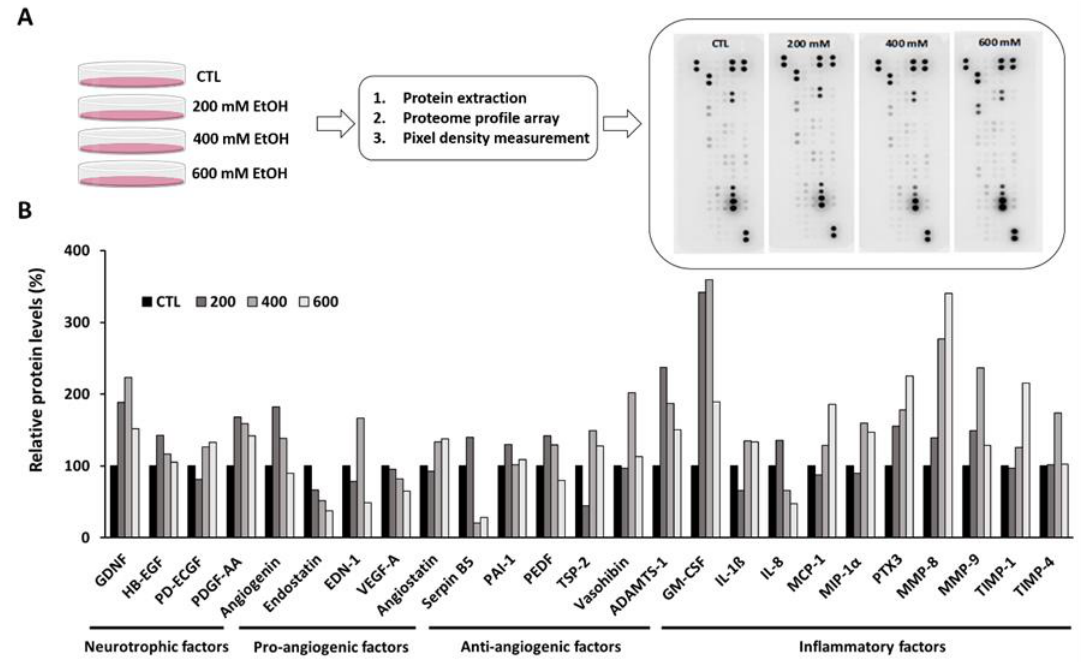
Figure 2. Proteome profile in ARPE-19 cells after EtOH exposure. ( A ) Workflow of the semi-quantitative proteomic analysis by antibody array system after 24 h of 200, 400 and 600 mM EtOH treatment in ARPE-19 cell. ( B ) Main neurotrophic, angiogenic and inflammation factors that experienced major changes. Values are expressed as the mean of pixel density signal of the pair of duplicate spots representing each protein.